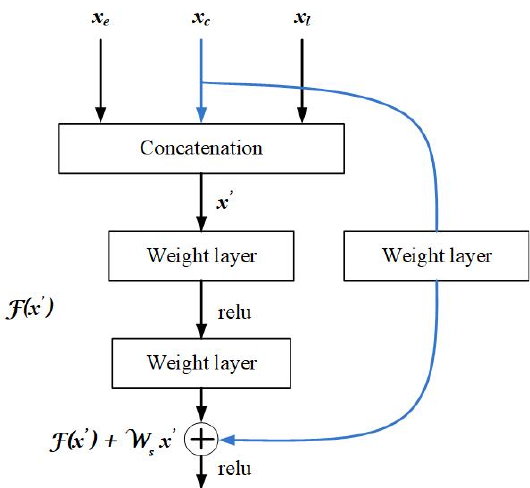
Figure 5. The proposed building block of residual learning for merging the three parallel Unets. x e denotes output features from the UNet for the early slice, x l denotes output features from the UNet for the later slice, and x c denotes output from UNet for the central slice, which is used in the skip connection for residual learning. Table 1. Architecture of the single UNet.